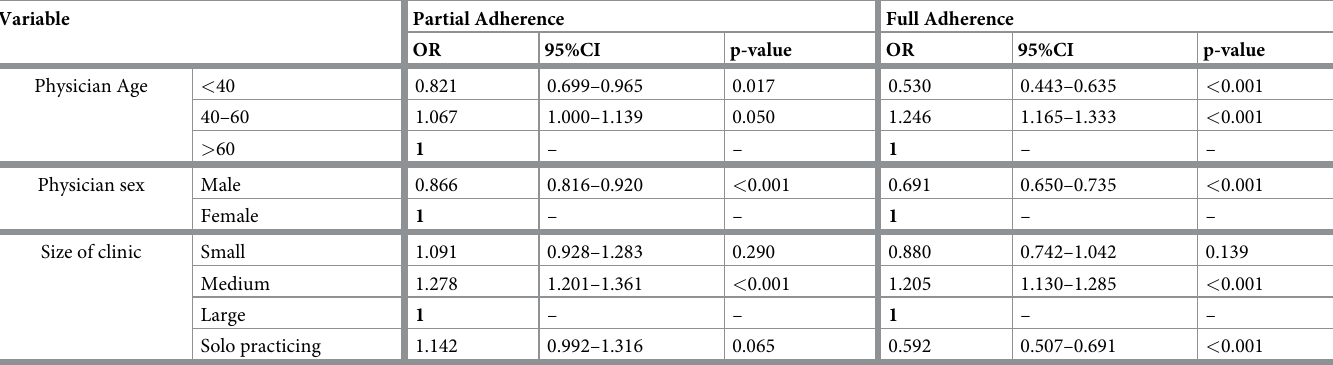
Table 4. Association between characteristics of the primary health provider and adherence over a six-year period.